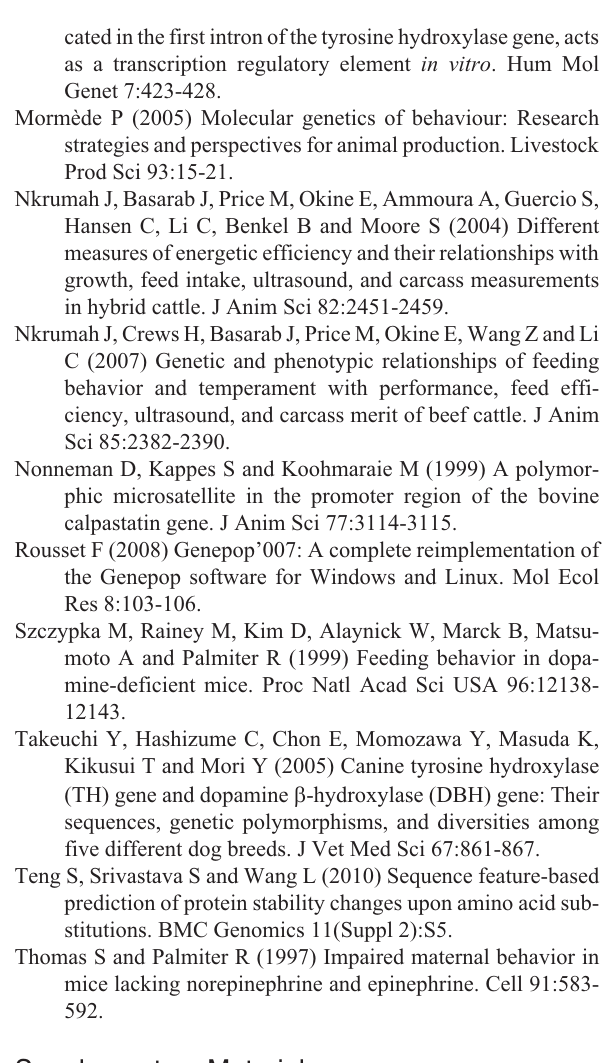
Table S1 - Primer sequences used to analyse bovine TH and DBH